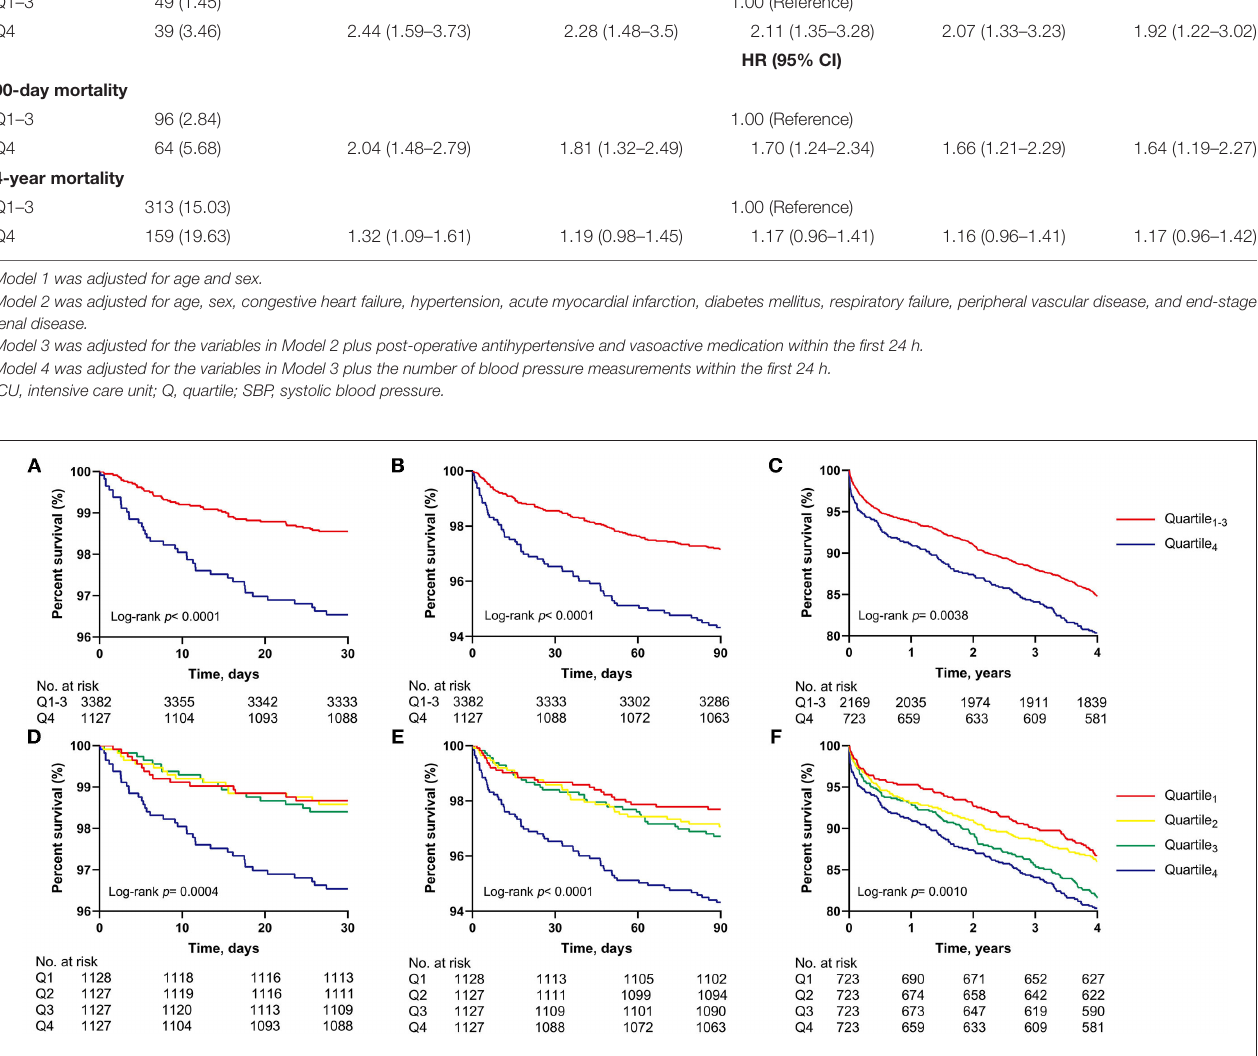
FIGURE 1 | Kaplan-Meier survival analysis among patients stratified by quartiles of the coefficient of variation of post-operative systolic BPV. Comparison of (A) 30-day, (B) 90-day, and (C) 4-year survival of the highest quartile (Q4) vs. the other three quartiles (Q1–3); Comparison of (D) 30-day, (E) 90-day, and (F) 4-year survival of the four quartiles; BPV, blood pressure variability; Q,